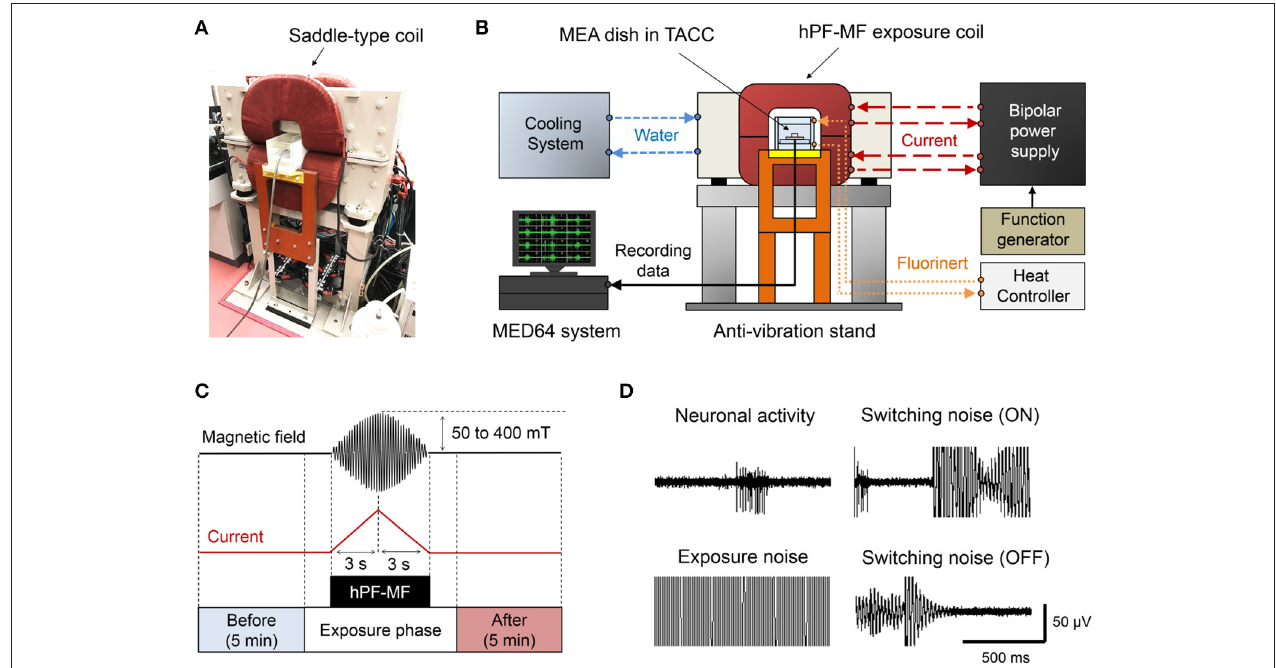
FIGURE 2 | The high-intensity power frequency magnetic field (hPF-MF) exposure system. (A) Photograph of the saddle-type hPF-MF exposure coil. (B) Schematic diagram of the system. Constant temperature water is flowing into the copper wire in the coil and thermostatic acrylic culture chamber (TACC), and the temperature is 20 and 42 ◦ C, respectively. The high-speed bipolar power supply is controlled by a function generator. The MEA dish is installed in the TACC and connected to the MED64 system. (C) Magnetic field exposure scheme. The electrical activity of the cultured neuronal network was recorded for 5min before and after hPF-MF exposure. To avoid mixing of artificial noise, data of a certain period before and after hPF-MF exposure were excluded. In addition, the hPF-MF was generated by a current input of a short time to the coil (rise time: 3s, fall time: 3s), resulting in a burst-like sweep waveform. (D) Example of incorporation of artifact noise. Extremely large switching noise and exposure noise superimpose on neuronal activity. Moreover, after the end of the exposure, the noise is reduced to the background